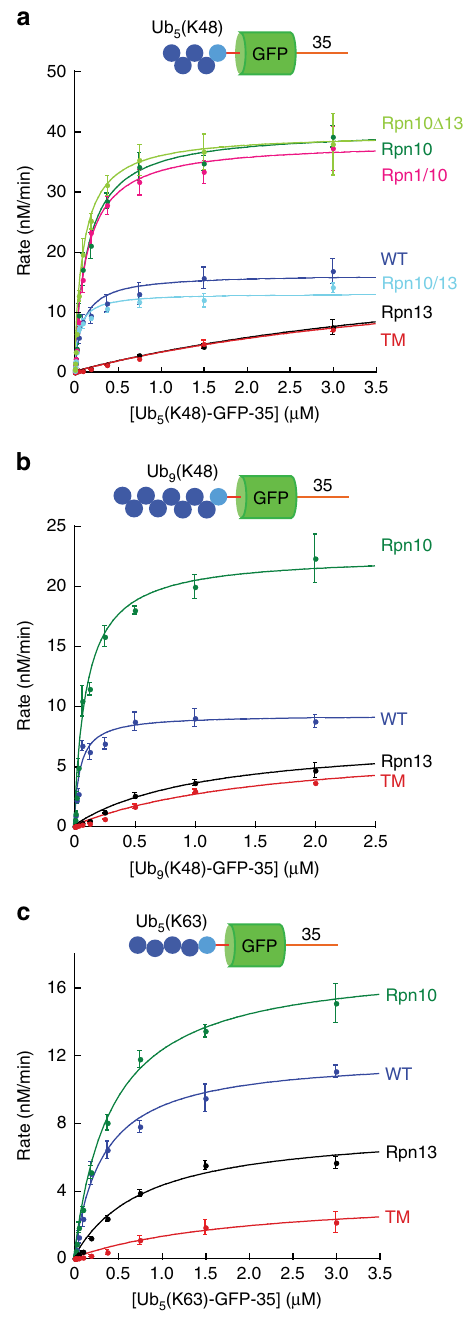
Fig. 6 Michaelis – Menten analysis of proteasomal degradation. Degradation of substrate proteins with three different ubiquitin chain modi fi cations by the indicated proteasome types was measured at 30 °C in the presence of 1 mM ATP and monitored by measuring GFP fl uorescence. The indicated concentrations of substrate were incubated with 25 nM proteasome, fl uorescence was recorded every minute for 120 min, and initial degradation rates were determined by curve fi tting. The graphs show the initial rates as a function of substrate concentration. a Ub 5 (K48)-GFP-35; b Ub 9 (K48)-GFP-35; c Ub 5 (K63)- GFP-35 by mutant proteasome. Error bars show standard errors derived from at least three replicate experiments. Source data are provided as a Source Data fi